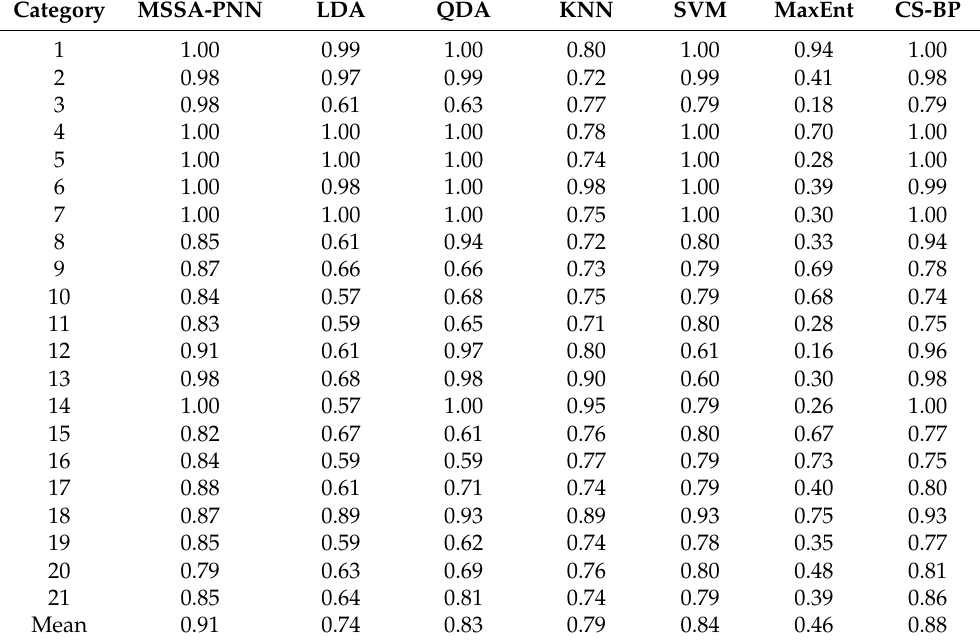
Table 11. The F1-score of MSSA-PNN and other classification